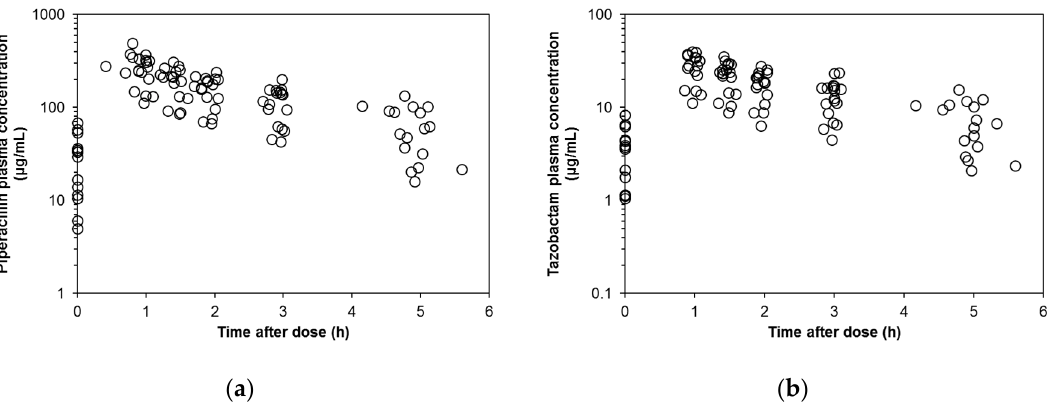
Figure 1. Piperacillin- and tazobactam-concentration–time data (100 samples each). ( a ) Piperacillin; ( b ) Tazobactam. Table 2. Estimate of population pharmacokinetic (PK) parameters of piperacillin (PIPC) in the final model.